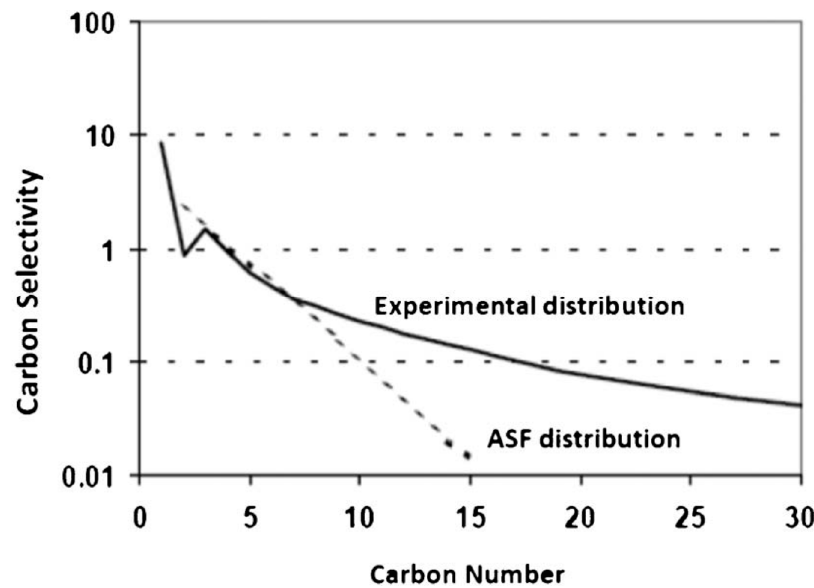
Figure 4. Experimental FTS product distribution in comparison to Anderson–Schulz–Flory (ASF). Reprinted with permission from [7]. Copyright (2012) RSC, Cambridge, England.